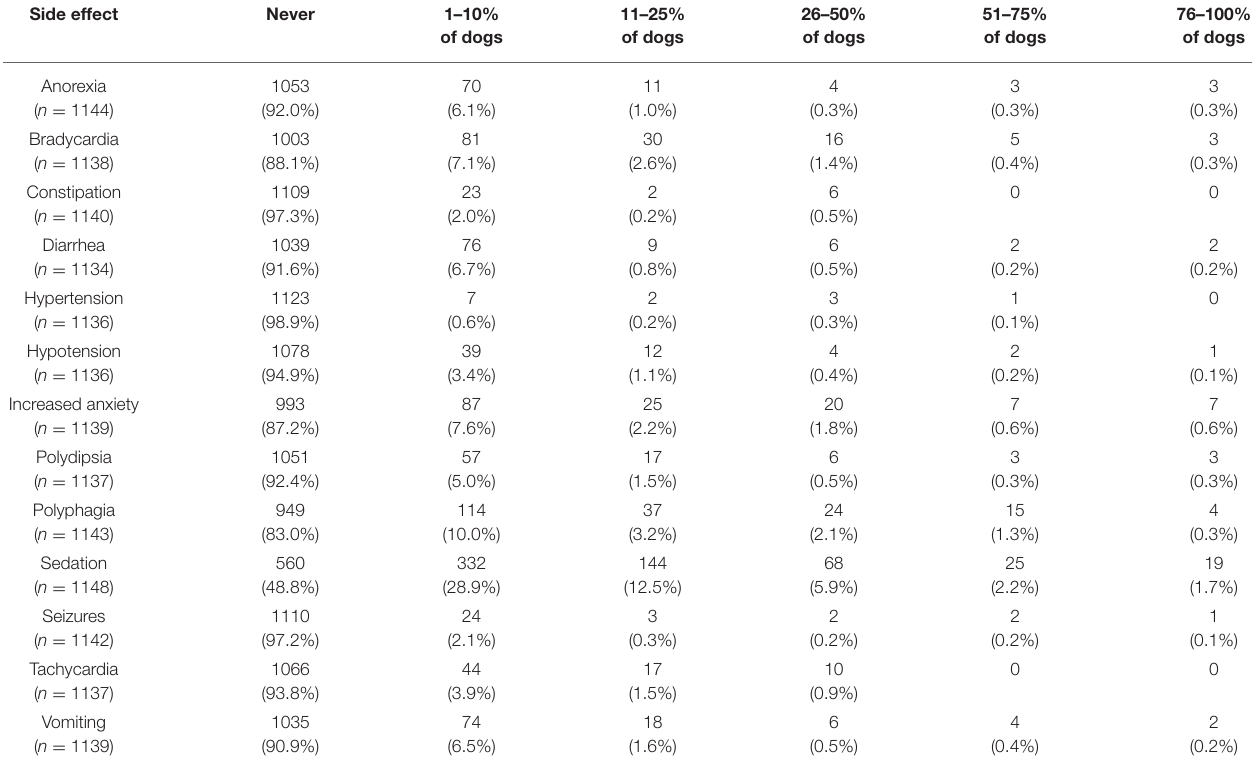
TABLE 6 | Perceived side effects of CBD products for common canine medical conditions.